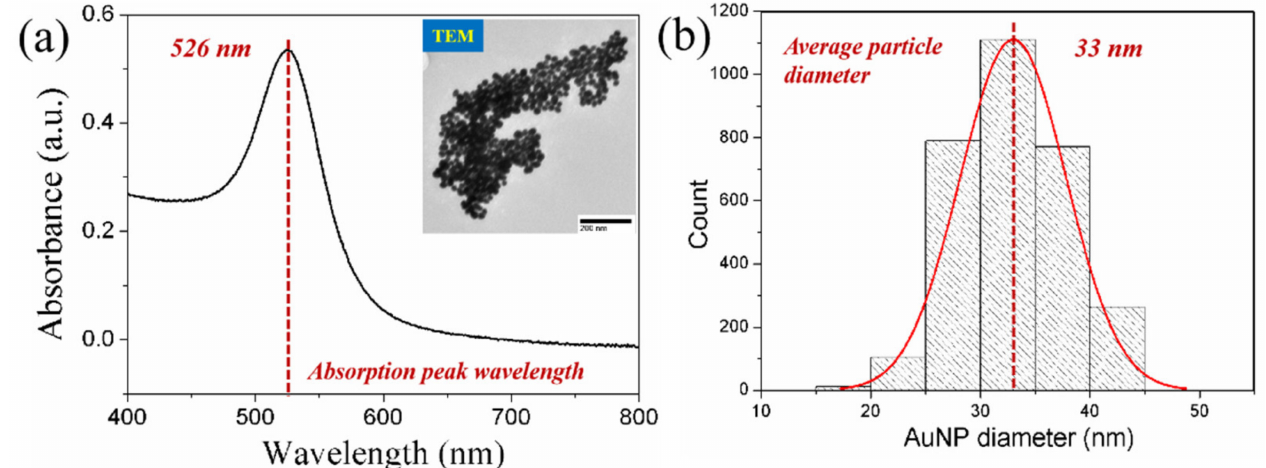
Figure 2. Gold nanoparticle characterization. ( a ) UV–vis spectrum and ( b ) diameter distribution of AuNPs of aver- age